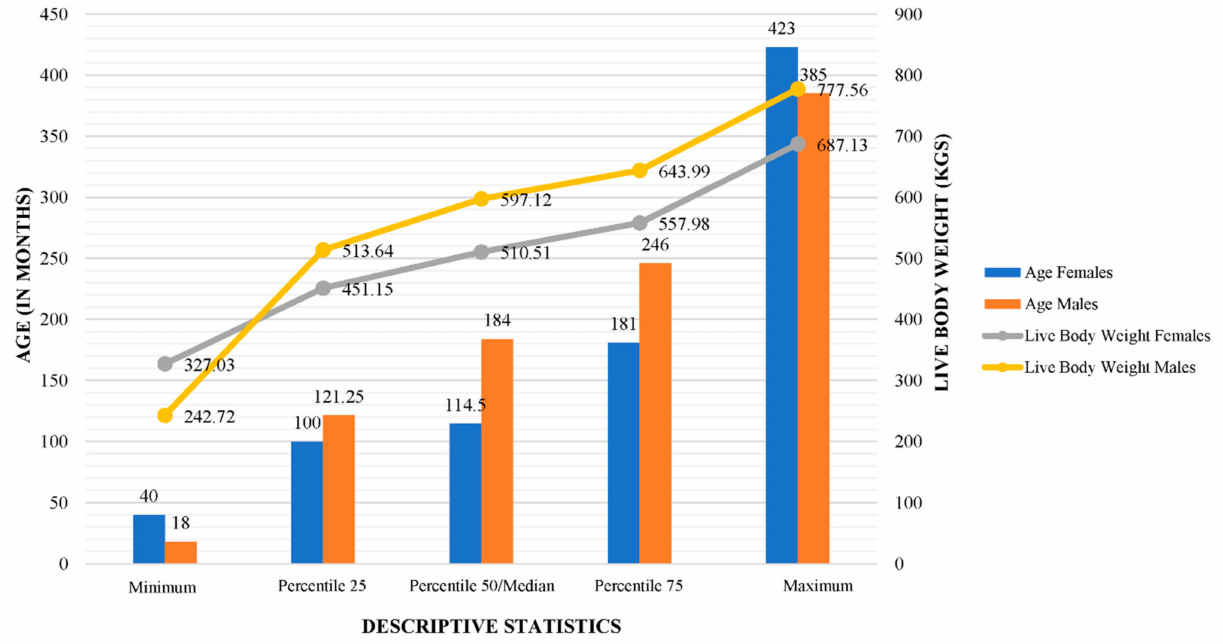
Figure 1. Descriptive statistics for age and live body weight in females and males,